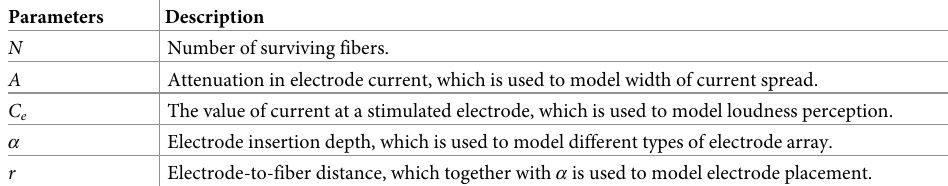
Table 1. Parameters in the modeling